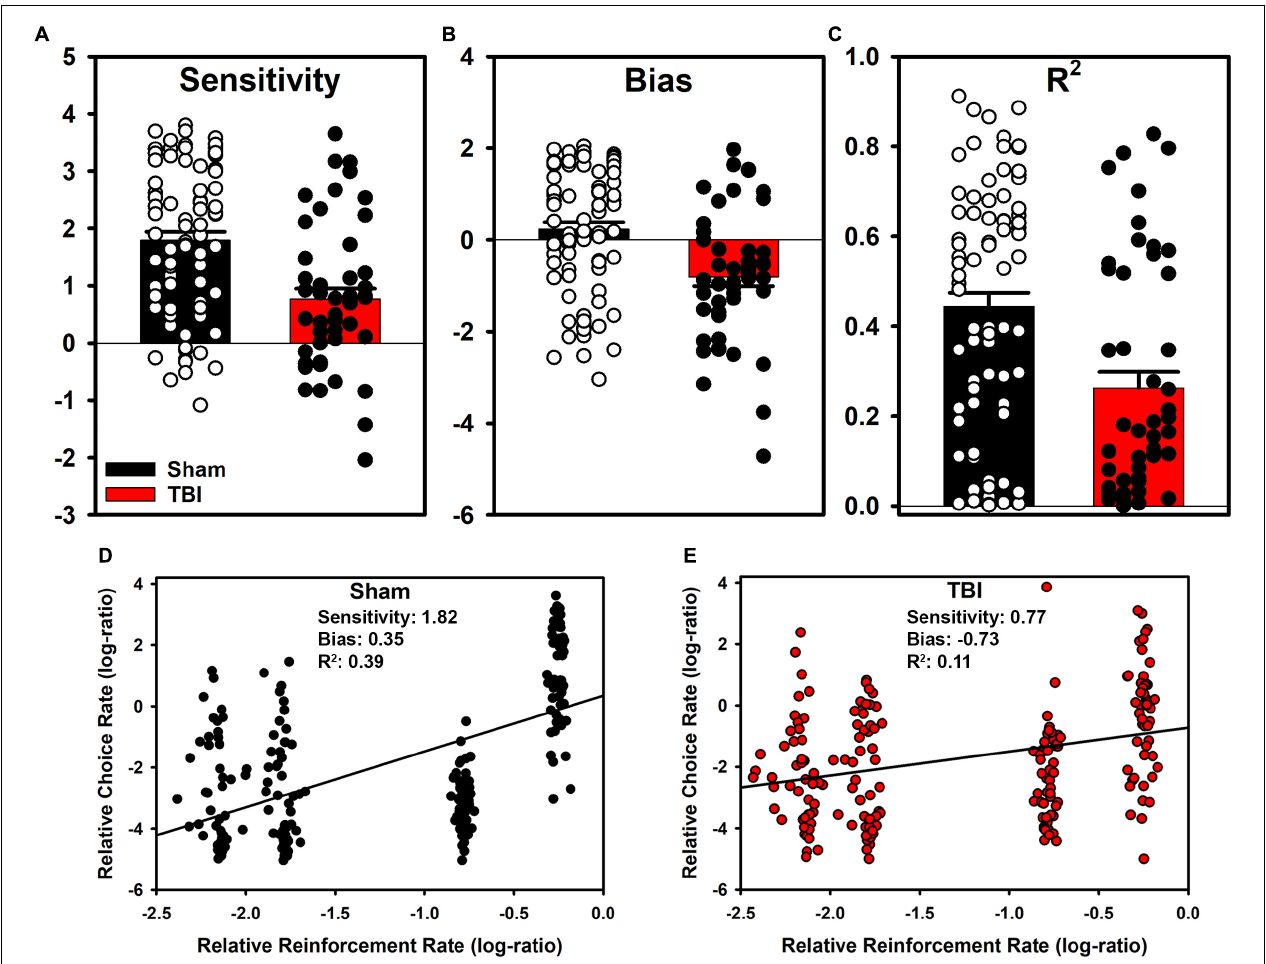
FIGURE 3 | Aggregate matching law parameters and group-level fits. (A) TBI reduced sensitivity ( p < 0.001), and (B) shifted bias toward suboptimal options ( p < 0.001). (C) The matching law described TBI rats more poorly than Sham ( p < 0.001), however the matching law did not describe data well at the individual or (D,E) at the aggregate level.